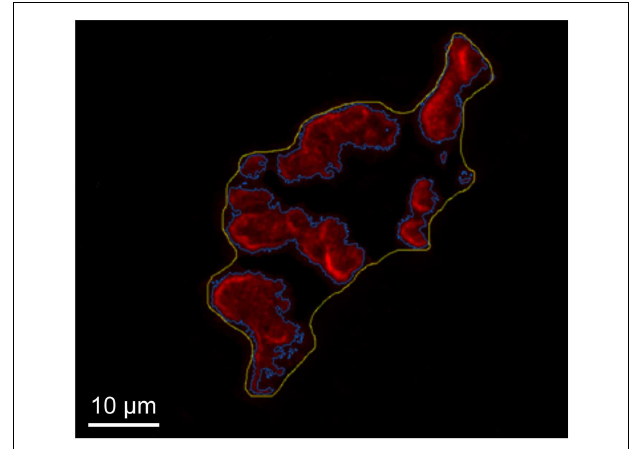
FIGURE 3 | Determination of post-synapticACh receptor cluster dispersion . Representative image of tracings made to determine total endplate area (yellow) and stained receptors clusters (blue) within that total area.To determine dispersion of AChRs within total endplate the stained area is divided by the total area and multiplied by